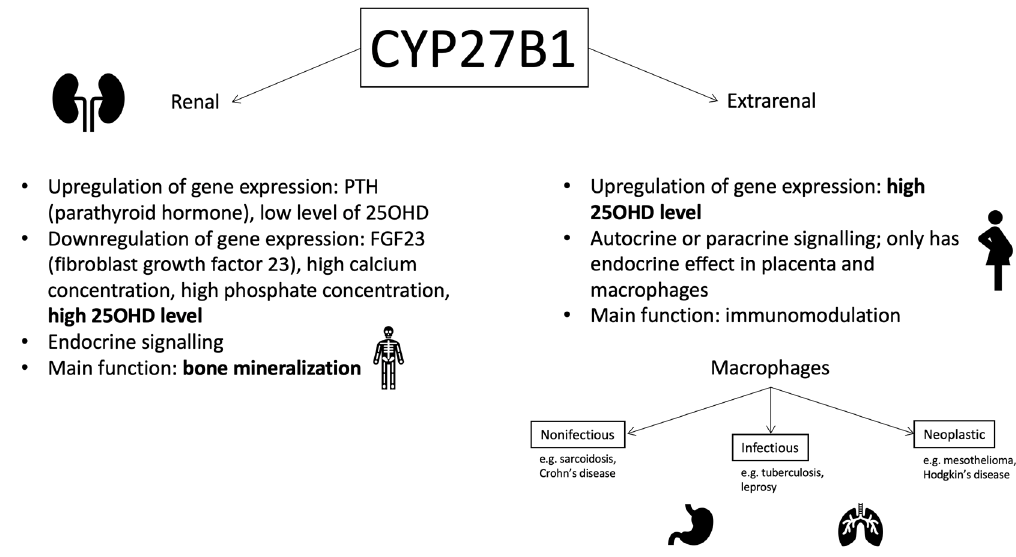
Figure 4. Different roles of CYP27B1 in the human body (based on Adams and Hewison 2012 [26], with own modifications).